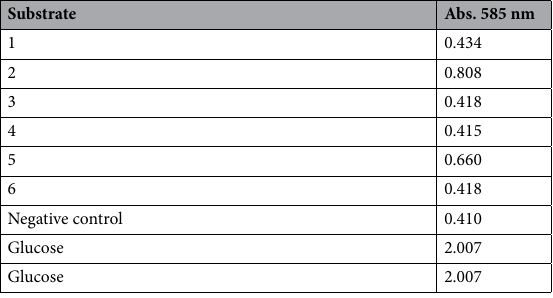
Table 3. Activity of glucose oxidase (GLUO) with test substrates and glucose, employed as positive control. Activity, as determined by Abs 585nm after 2 h, was observed with substrates 2 and 5 at 1 mM scale. As negative control the enzymatic reaction without the addition of any substrate has been